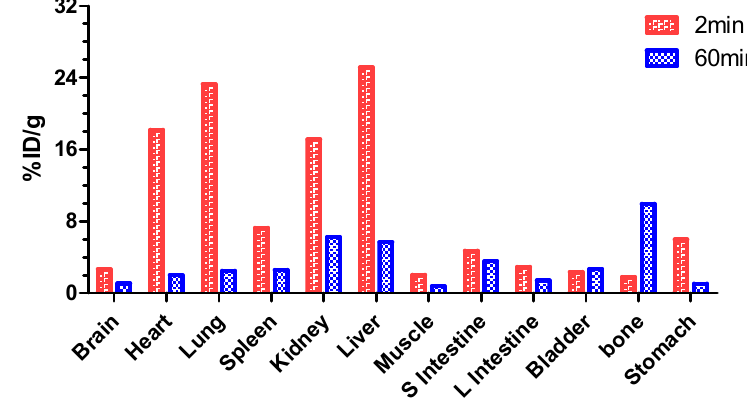
Figure 7. Biodistribution of [ 18 F]FOFA {[ 18 F]F- 1 } in healthy male SD rats. The two rats were injected intravenously with 0.1 mCi and were euthanized and dissected after injection at 2 min and at 60 min, respectively. Data are presented as %ID/g. The measurement was performed in triplicate.